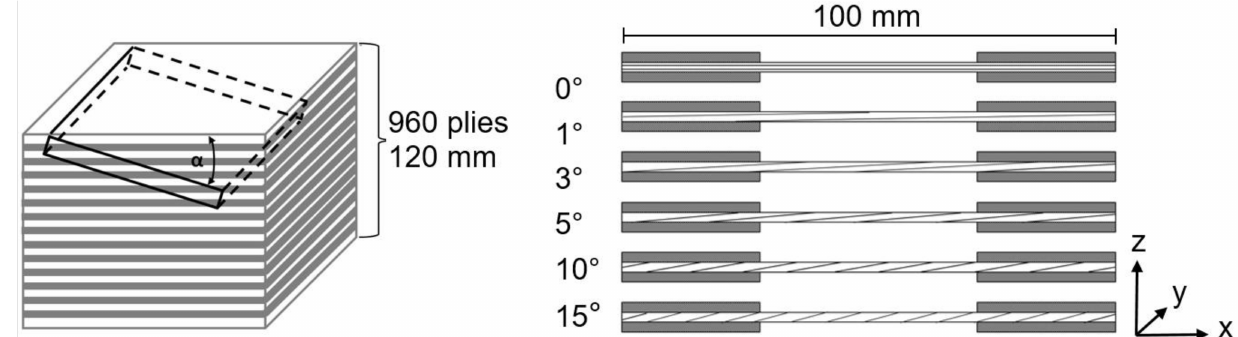
Figure 1. Schematic representation of a cube consisting of 960 plies used to cut specimens with out-of-plane fibre angles with respect to the panel surface. Schematic cross-sections of tensile test specimens are shown on the right side.